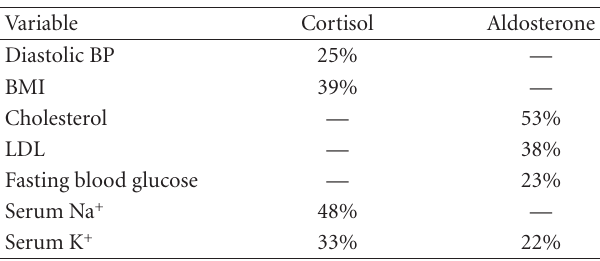
Table 4: Measure of coe ffi cient determination ( r 2 ) showing the proportion of variance shared among two variables in pre-HTN group.